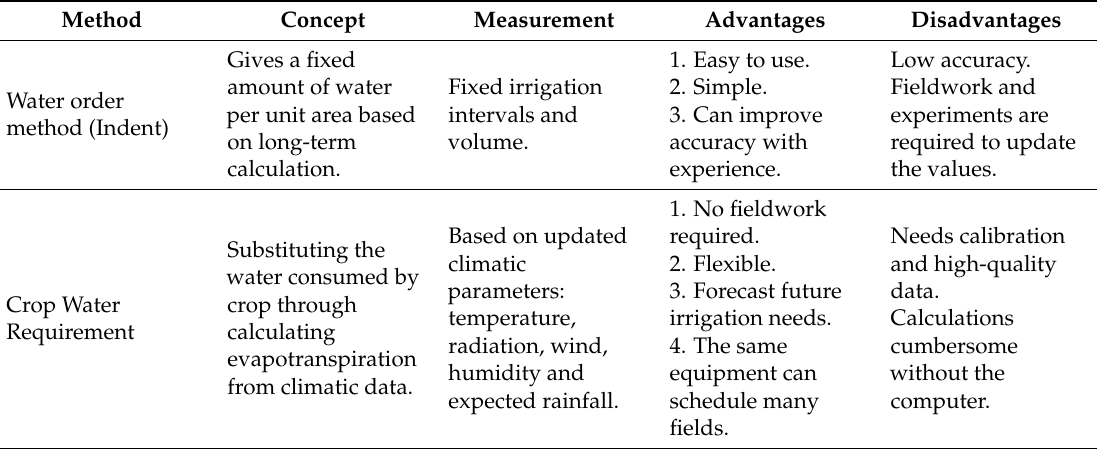
Table 3. Comparison between the Indent method and crop water requirement method.